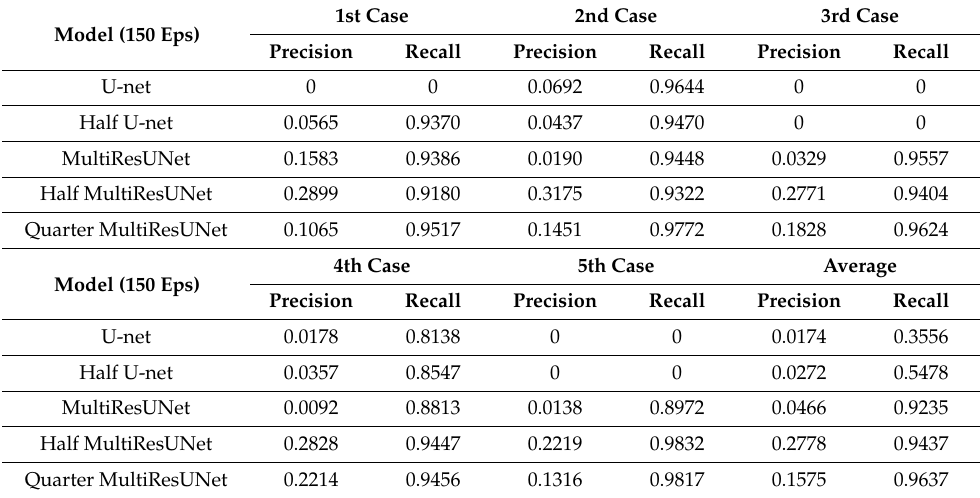
Table 1. Precision and recall of five neural